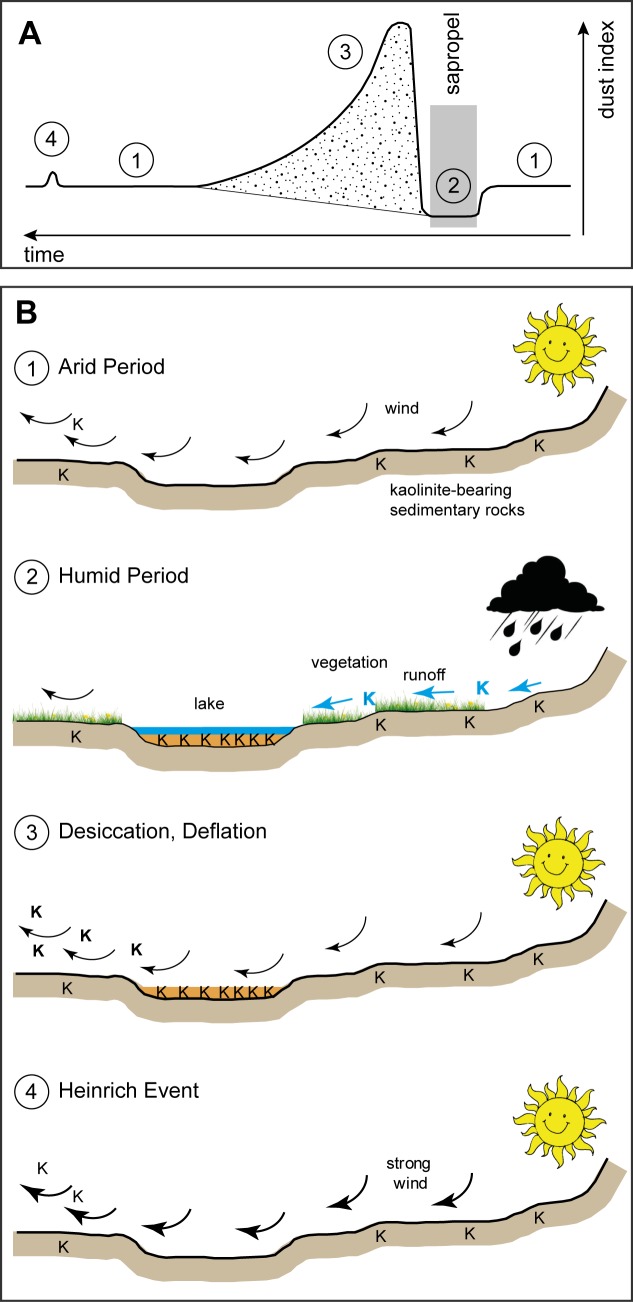
Conceptual model of dust dynamics.(A) Changes in the quantity of fine-grained dust influx to the EMS with time. 1: Background level; 2: Pluvial phase with sapropel formation; 3: Dust phase, 4: Glacial drought. The dotted area was used to calculate the dust index. (B) Sketches for the individual phases labelled in panel (A). 1: Arid periods with restricted deflation of kaolinite from kaolinite-bearing sedimentary rocks. 2: Cessation of aeolian transport of kaolinite during humid periods due to vegetation and reduced wind activity. Clay-rich erosion products accumulate in lake basins. 3: With the return of arid conditions, the kaolinite-rich lake sediments are blown out from the desiccated basins leading to maximum kaolinite influx to the Eastern Mediterranean Sea. 4: Intensified aeolian activity during glacial droughts (Heinrich Events) causes minor kaolinite maxima.